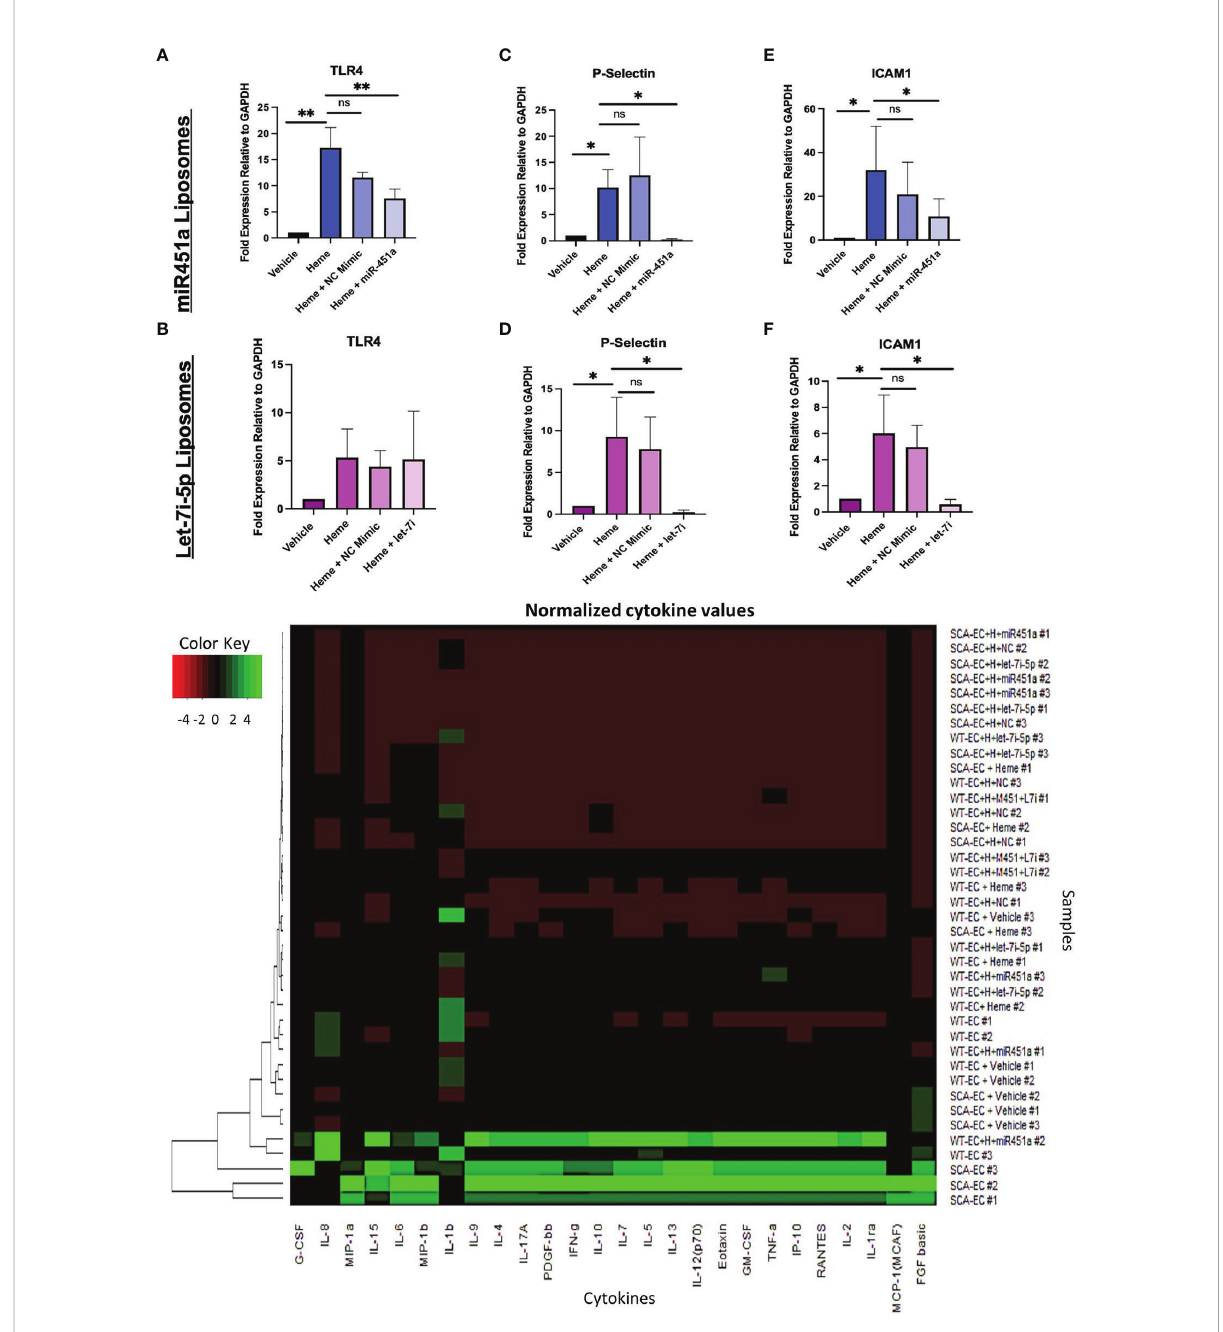
FIGURE 3 Liposome Treatment of Endothelial Cells (A – F) RT-qPCR of total mRNA expression of TLR4, ICAM1, P-Selectin in hWT-ECs treated with indicated miRNA-loaded liposome for 24 hrs. Heme + NC Mimic = hWT-ECs treated with liposomes loaded with negative control nucleic acid mimic. Heme + miR-451a = hWT-ECs treated with liposomes loaded with miR-451a nucleic acid mimic. Heme + let-7i = hWT-ECs treated with liposomes loaded with let-7i-5p nucleic acid mimic. ANOVA was completed followed by individual paired t-test of heme treatment group with other treatment groups for statistical analysis (n=3). No signi fi cant difference was found in TLR4 mRNA expression after let-7i-5p liposomal treatment of hWT-ECs. (G) Heatmap of Normalized cytokine concentration as determined through cytokine multiplex assay of hWT-ECs and heme treated SCA-ECs after 24 hr. treatment of miR-451a, let-7i-5p, or both miR-451a and let-7i-5p loaded liposomes for 24 hrs (n=3). ns indicates no signi fi cant difference, * indicates p < 0.05, ** indicates p < 0.01 for all bar